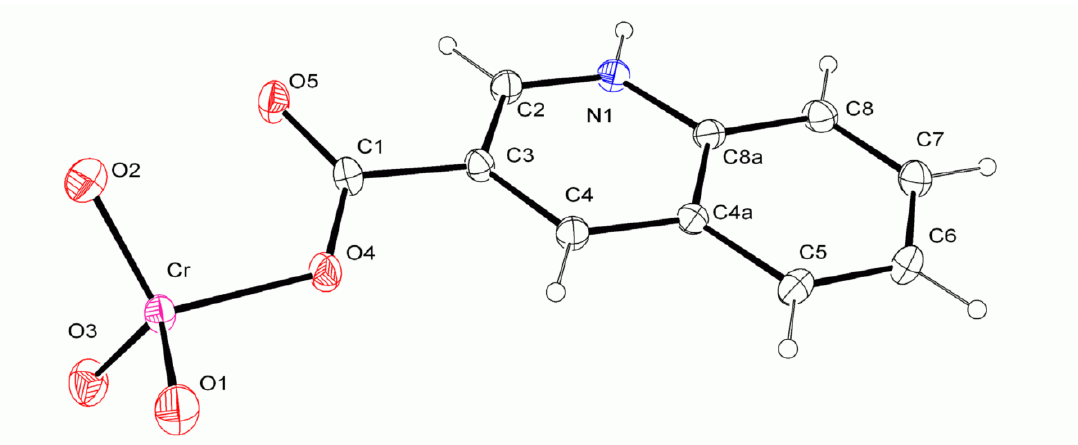
Figure 1. ORTEP view of (quinolinium-3-carboxylato-O)trioxidochromium(VI) showing the atom numbering. The thermal ellipsoids for the non-hydrogen atoms are drawn at the 50% level of